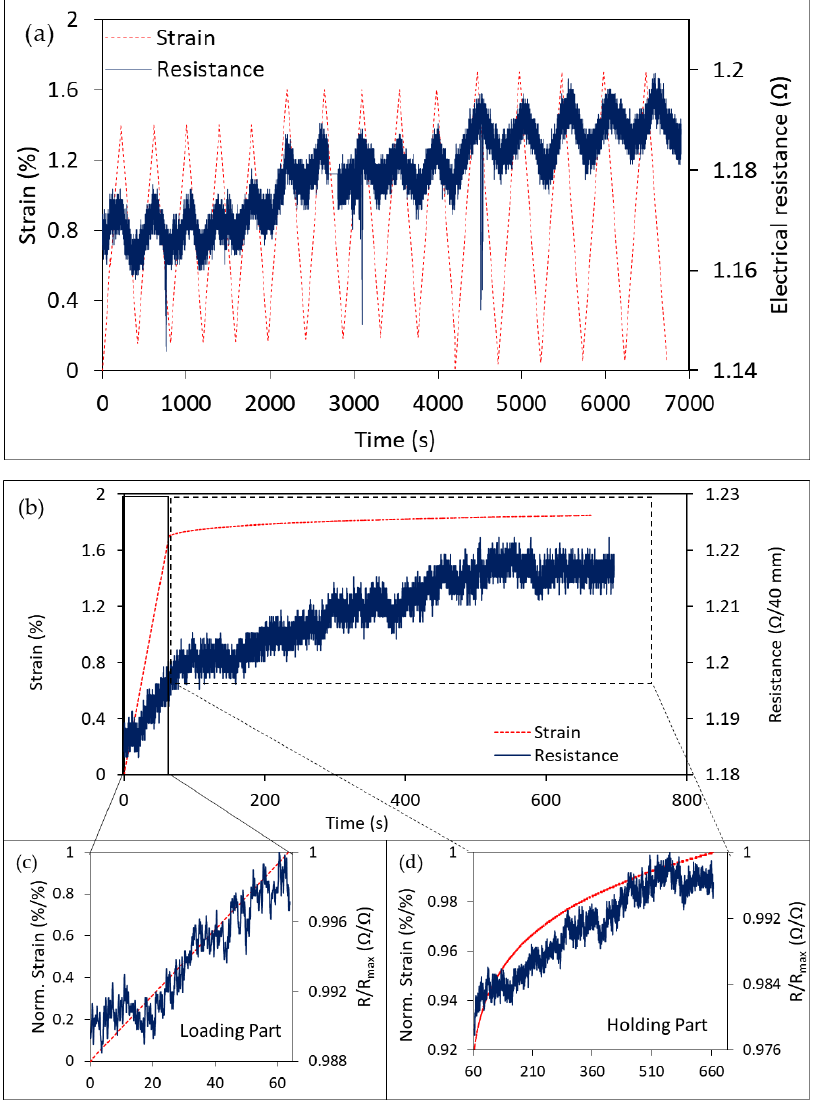
Figure 9. ( a ) Electrical resistance response to the induced mechanical strain in the loading–unloading tensile test at differ- ent strain levels and ( b ) electrical resistance response to creep-like test, ( c ) and ( d ) are the enlarged views of the loading and holding parts in ( b ), respectively, and are normalized with respect to the maximum value at each part.